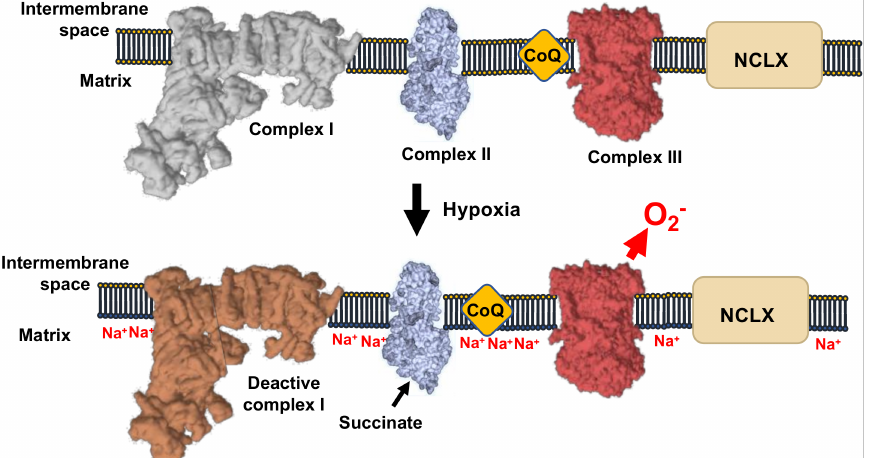
Figure 4. Mechanism of ROS production in hypoxia. CI-deactivation upon oxygen reduction induce de acidification of the mitochondrial matrix, the subsequent solubilization of matrix Ca 2+ precipitates. The concomitant elevation of Ca 2+ concentration activate the Ca 2+ /Na + antiporter (NCLX). This causes the elevation of Na + that decrease the inner membrane fluidity affecting the free CoQ diffusion and increase ROS production by